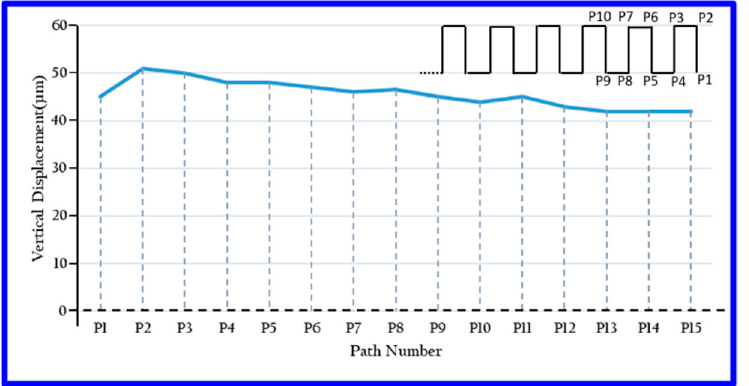
Figure 18. Display of the vertical displacement of the pilot node vs. the number of paths (P i -P i+1 is a part of the zigzag path traveled by the ball).